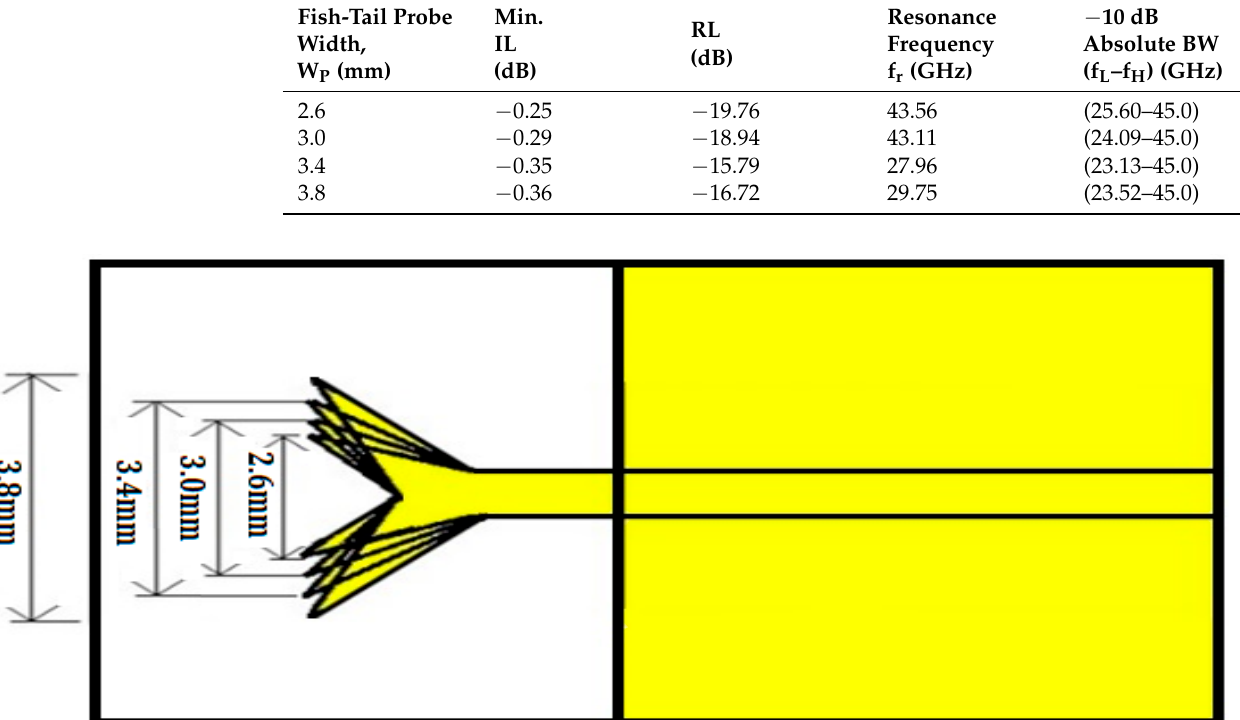
Figure 7. Fish-tail width variation with a step size of 0.4 mm.